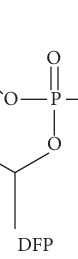
Figure 1: Diisopropylfluorophosphate